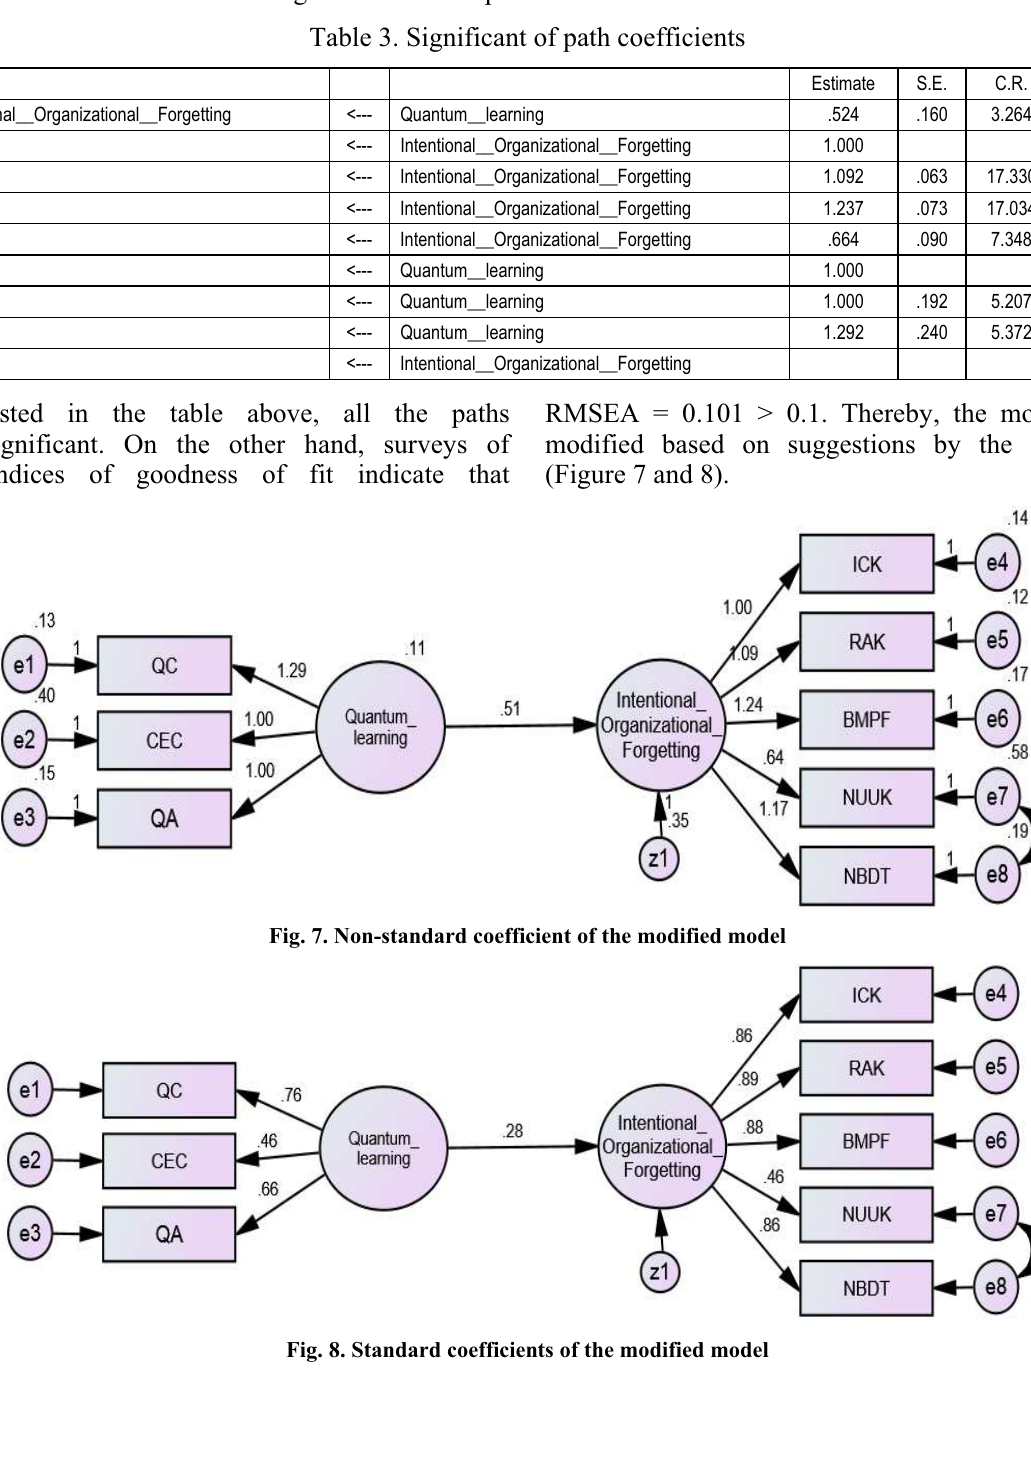
Fig. 8. Standard coefficients of the modified